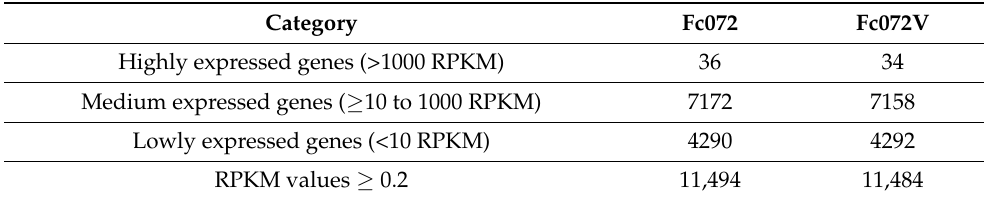
Table 3. RNA-Seq gene expression results for the two conditions.